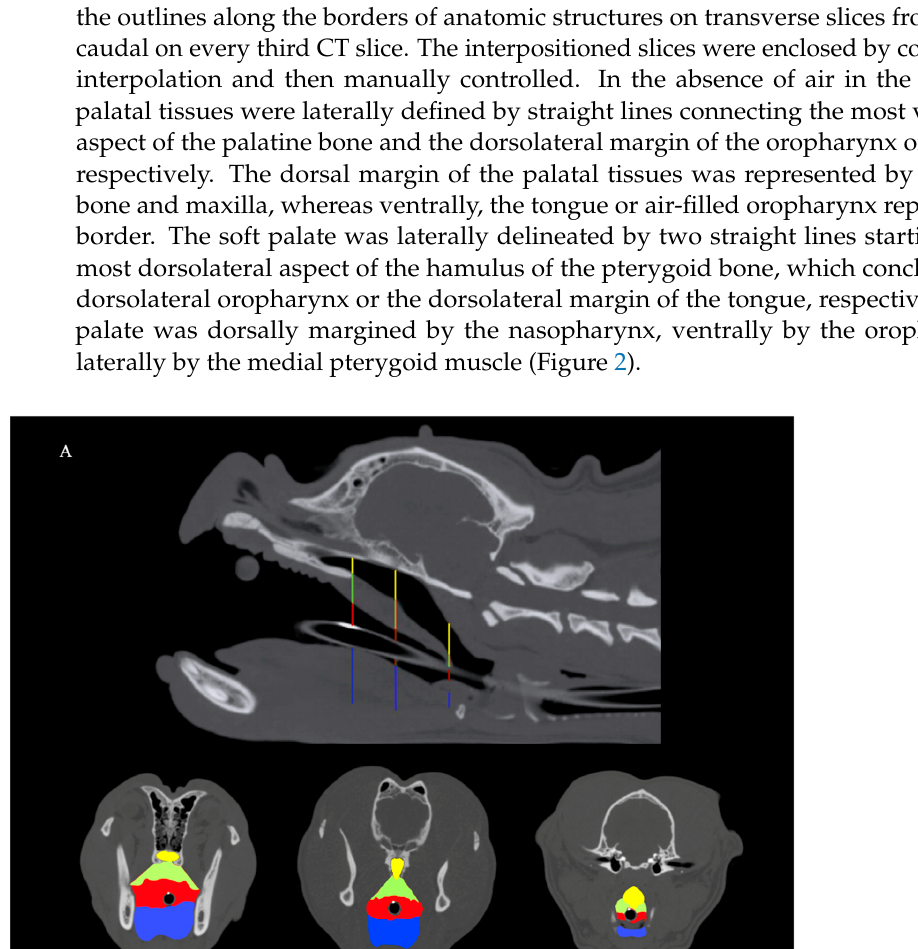
− 100 and − 200 to 150 HU, respectively. Outlines of the areas of interest were determined by segmentation techniques, using manual adjustments of the window level when draw- ing the outlines along the borders of anatomic structures on transverse slices from cranial to caudal on every third CT slice. The interpositioned slices were enclosed by computa- tional interpolation and then manually controlled. In the absence of air in the oropharynx, palatal tissues were laterally defined by straight lines connecting the most ventrolateral